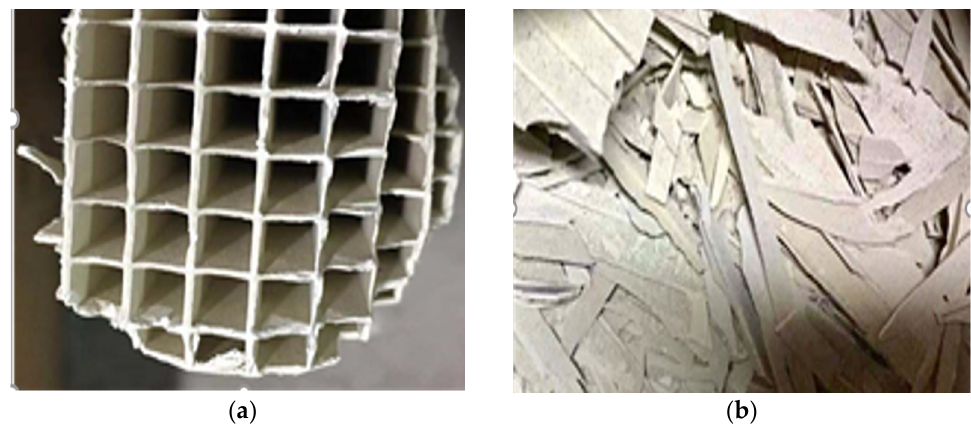
Figure 1. The macroscopic morphology of spent SCR catalysts ( a ) before crushing and ( b ) after crushing.